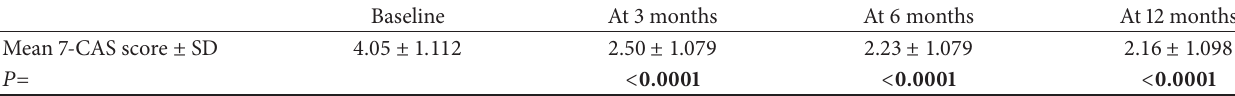
Table 2: 7-CAS results before and after 3, 6, and 12 months of methotrexate therapy.